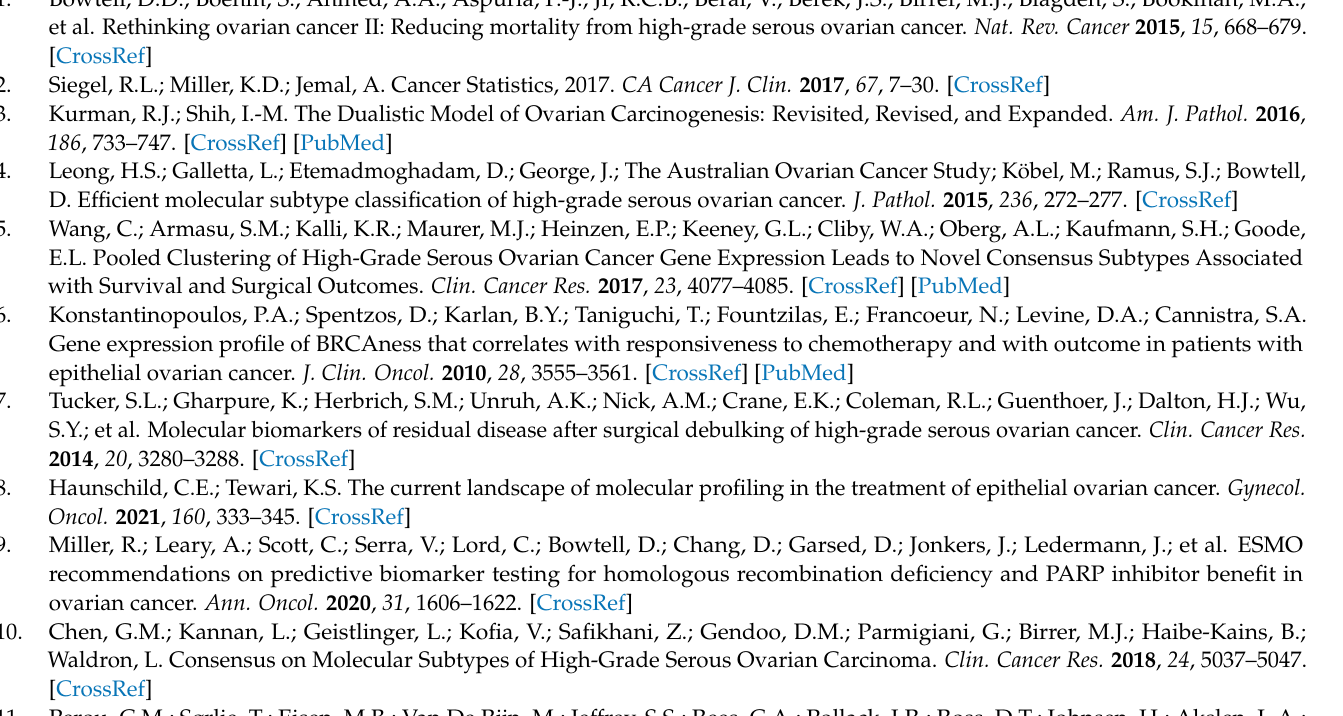
measured by qPCR. Figure S3: The original western blotting figures and densitometric analysis. Figure S4: The original western blotting figures sorted CD44 + /CD24 − . Figure S5: List of genes differentially expressed (DEGs) between CL and non CL